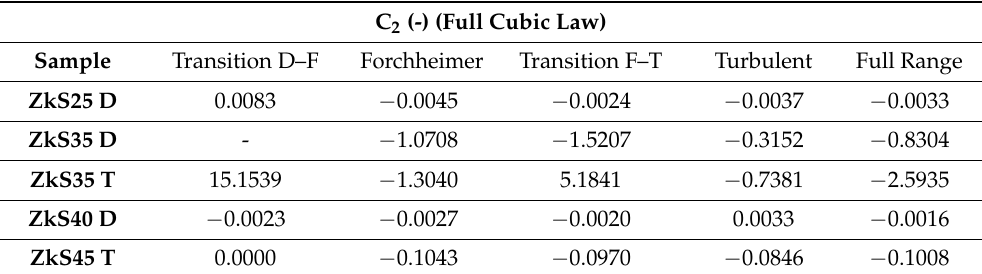
Table 5. The cubic coefficient fitted using the full cubic law for all regimes of air flow through ESR